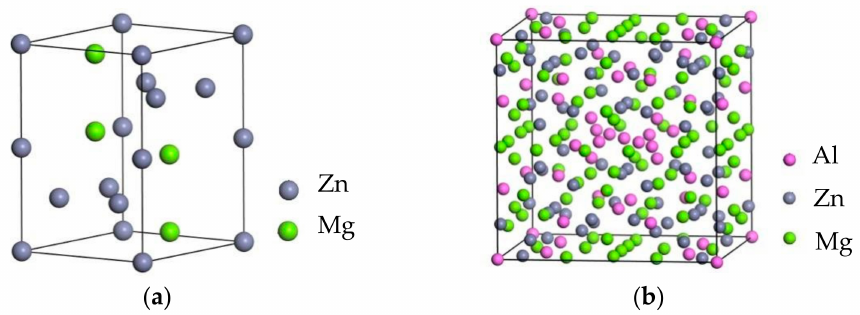
Figure 1. Crystal structure: ( a ) MgZn 2 ; ( b ) T-(Al,Zn) 98 Mg 64 . According to the symmetry of Im3 space group (cubic crystal), four configurations of Al: Zn: Mg = 13: 36: 32 and Al: Zn: Mg = 25: 24: 32 were constructed, as Al and Zn atoms occupied site B, C, and F sites respectively [14]. The space group of the calculation model and the space occupying situation were shown in the Table